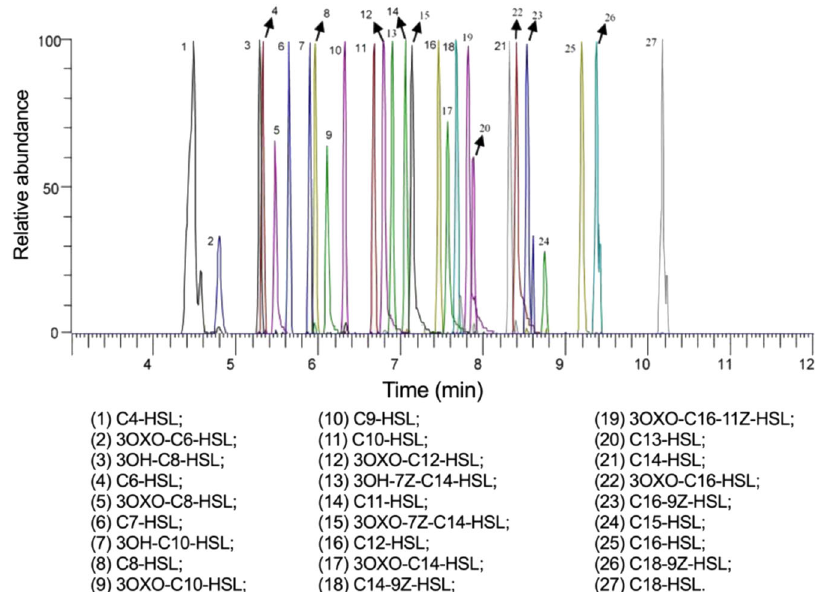
Fig. 1 Chromatograms of N-acyl homoserine lactones (AHLs). Typical UPLC-ESI-MS/MS chromatograms of 27 AHLs generated by AHL chemical